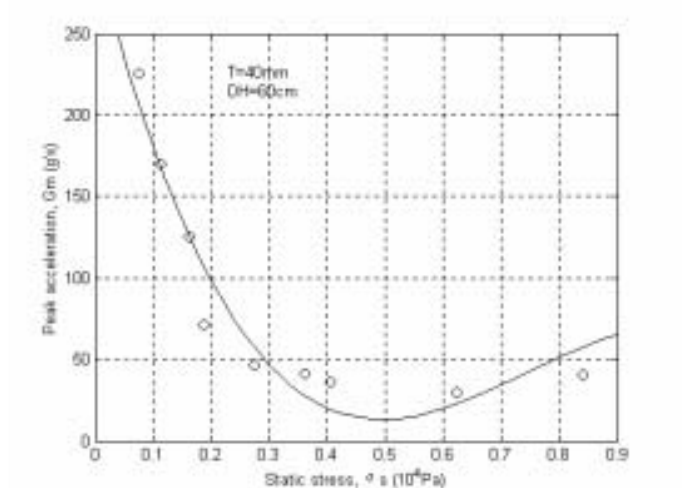
Fig. 4. Dynamic cushion curve of honeycomb paperboard.